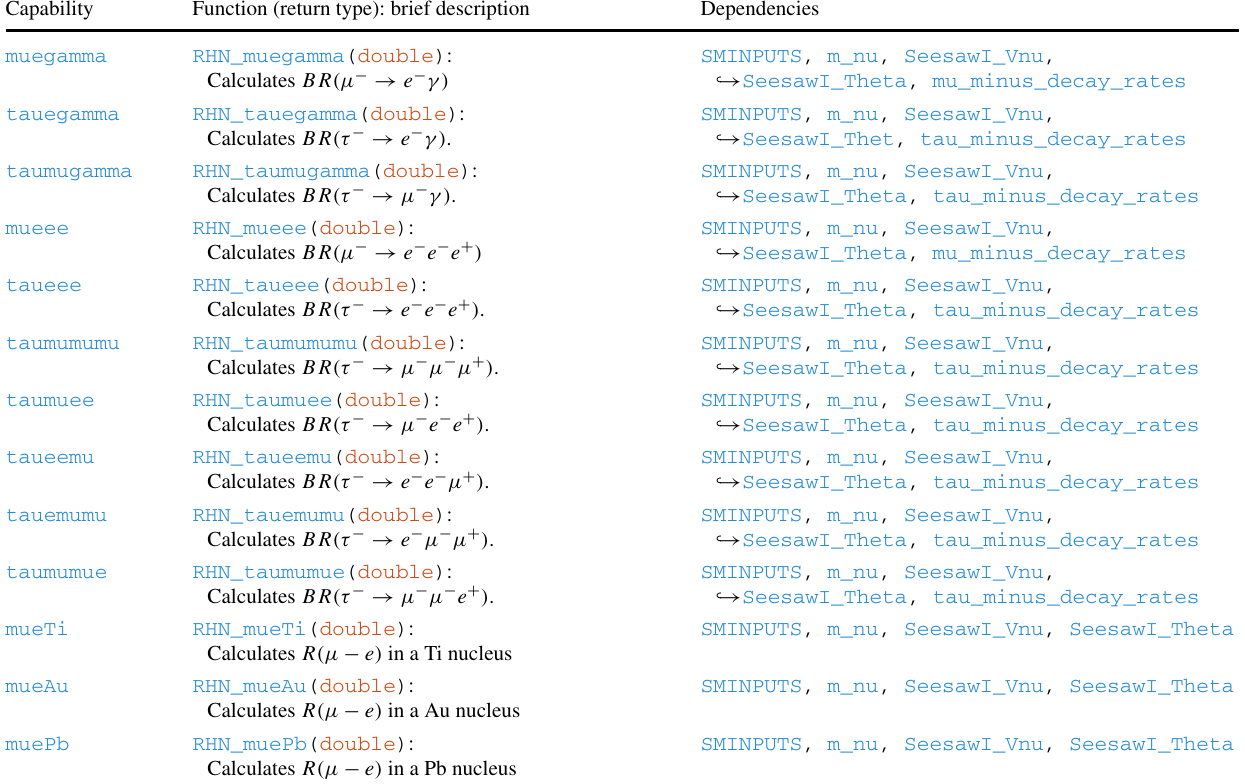
Table 11 Capabilities and module functions to calculate LFV observables Capability